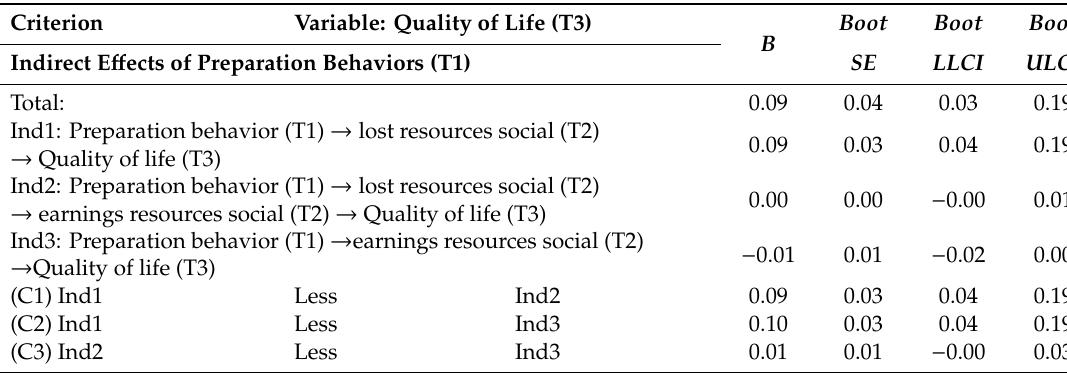
Table 6. Comparison of the indirect e ff ects of preparation behaviors (T1) through social resources losses (T2) and gains (T2) in the prediction of quality of life (T3).